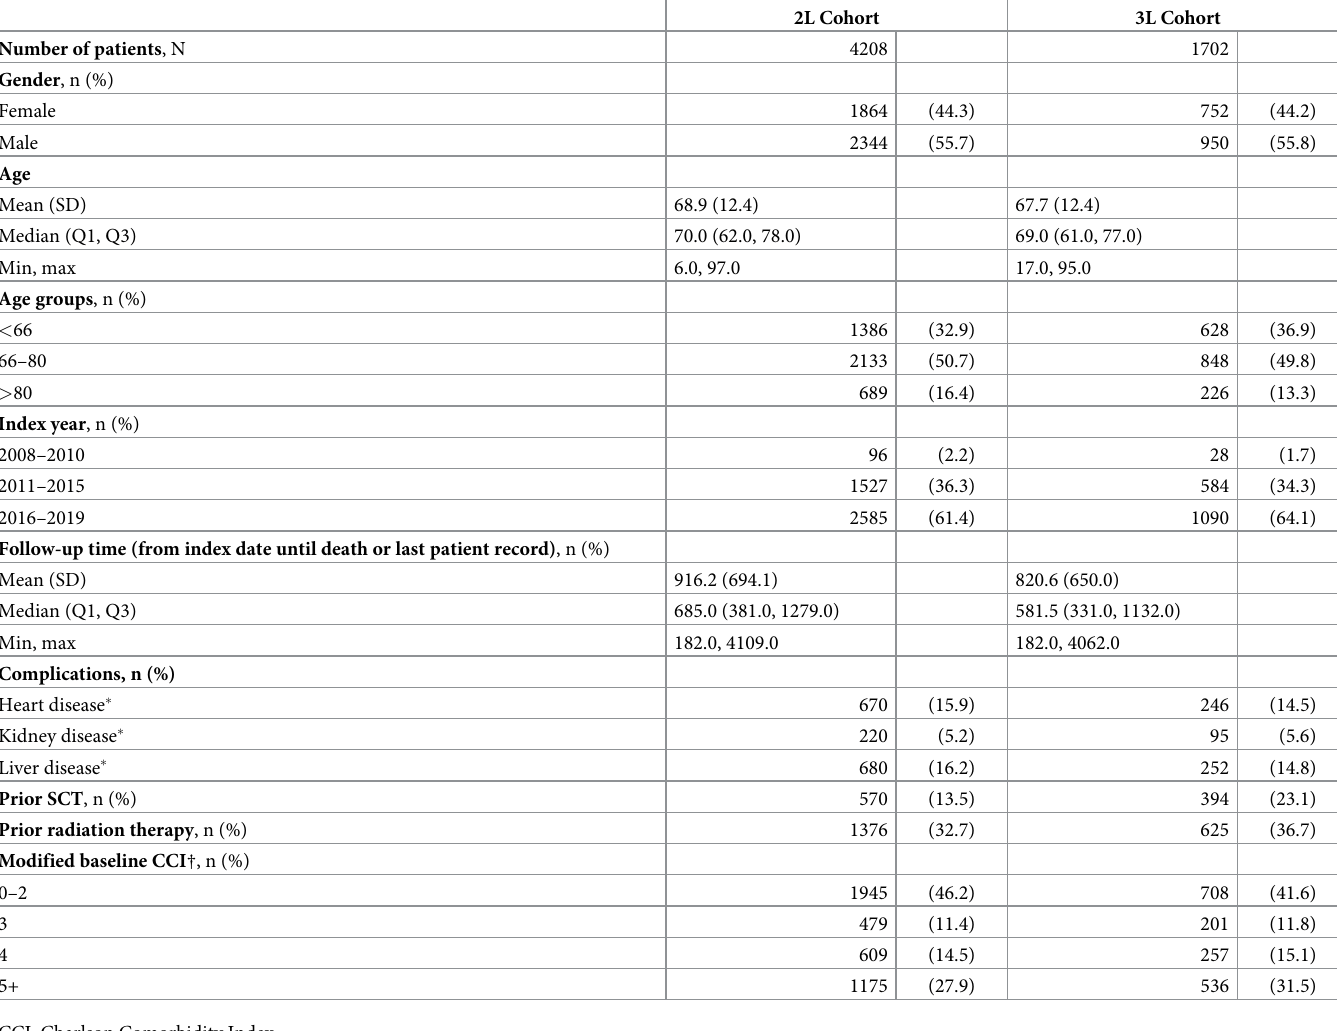
Table 1. Characteristics of rrDLBCL patient